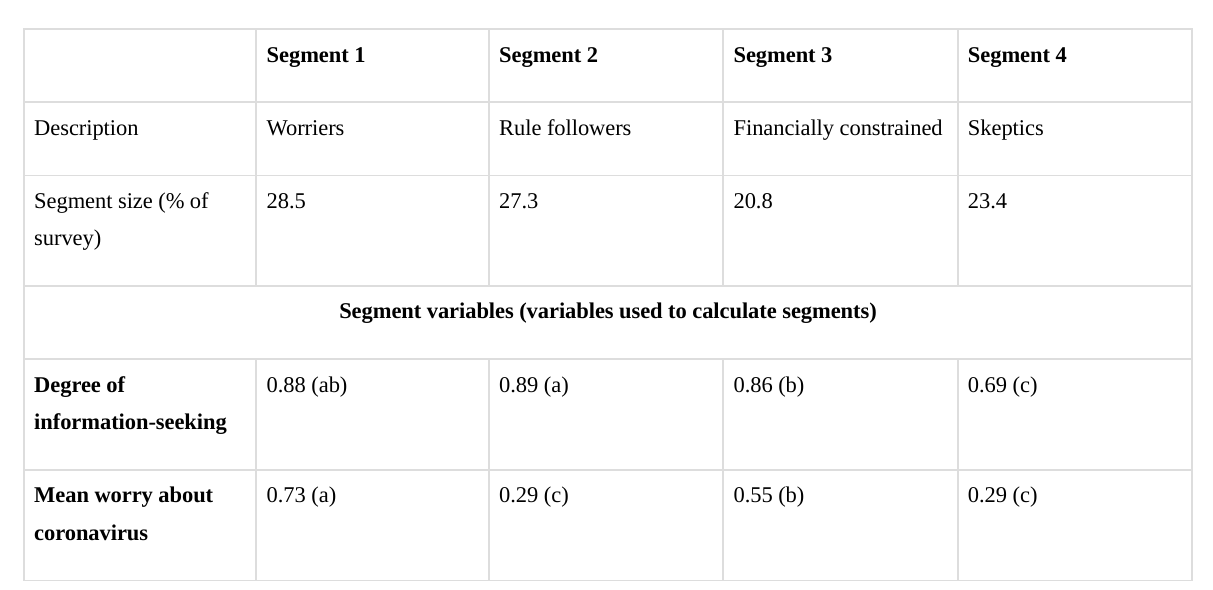
Table 2. Characteristics of the four population segments identified and profiling variable